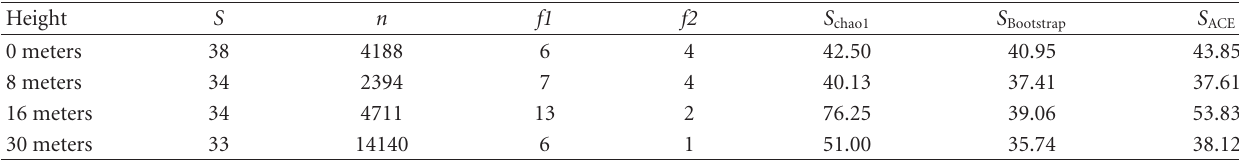
Table 6: Richness estimates to the forest strata (heights).